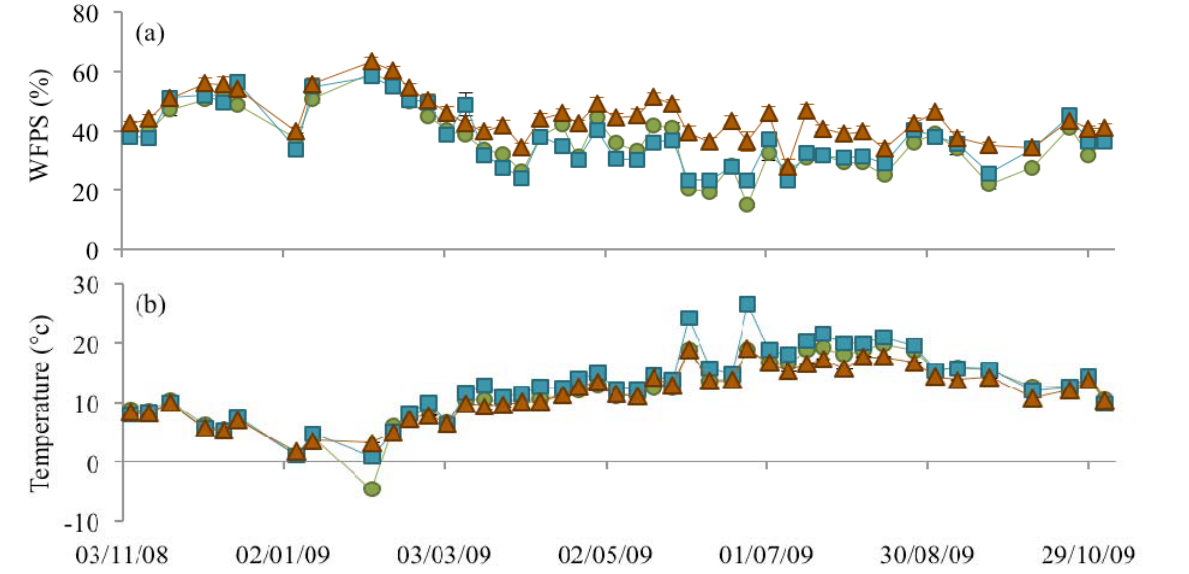
Figure 4. Mean ( a ) water filled pore space (WFPS) (%) and ( b ) soil temperature (°C) ± SE (n = 8) from November 2008 to November 2009 from three land uses: G ( ● ), NM ( ■ ) and EM ( ▲ ).